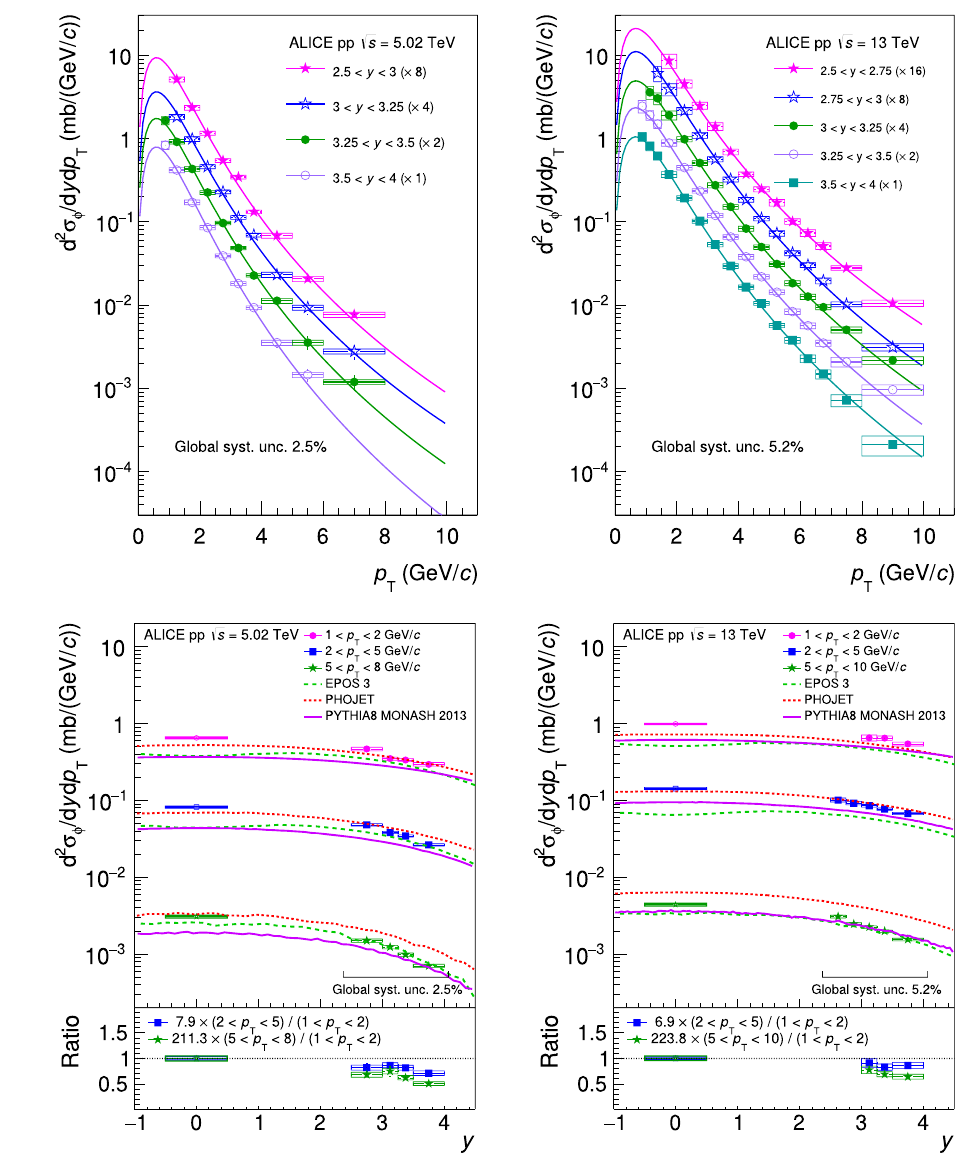
Fig. 5 Differential φ meson production cross section d 2 σ/ d y d p T as a function of p T √ s = 5 . 02 TeV (left) and √ at s = 13 TeV (right) in several rapidity intervals. The boxes represent the systematic uncertainties, the error bars the statistical uncertainties. Data are fitted with a Levy–Tsallis function